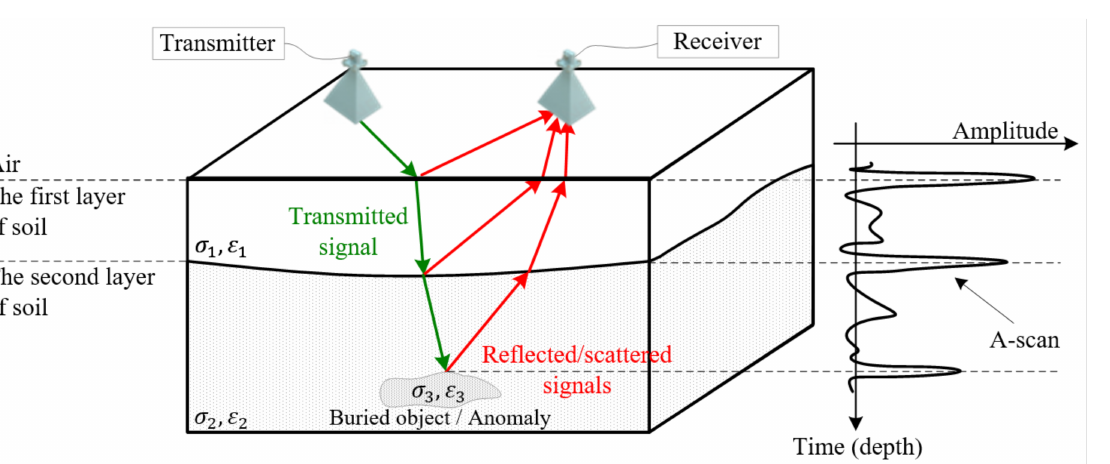
Three types of visual presentations of GPR radargrams are used in practice [3,14,16,21]. A single echogram was obtained for only one GPR antenna position with coordinates ( i , j ) is a one-dimensional signal representation, called an A-scan (Figure 2a). Time delays of the signal peaks in the A-scan are usually converted into respective depths and the Z-axis is scaled in the distance units